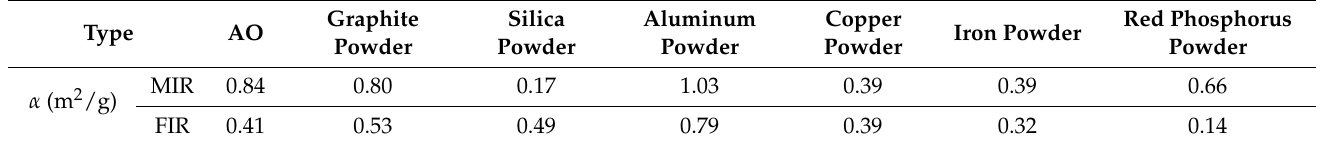
Table 3. Comparison of mass extinction